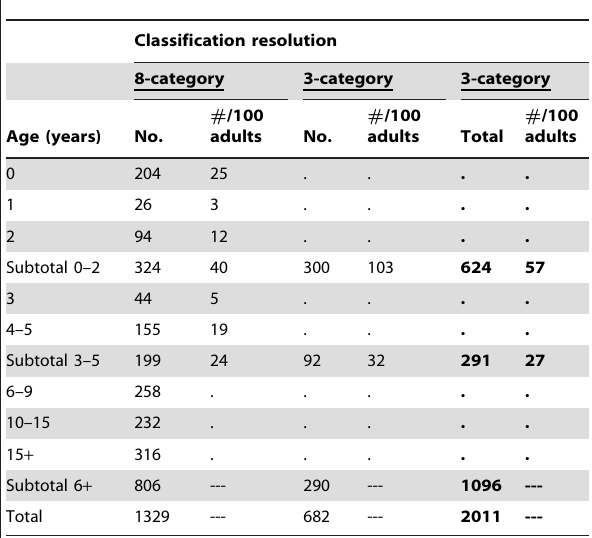
Table 3. Numbers of female and young (known males removed) Pacific walruses in each age class based on 8- category and 3-category classifications of samples from herds hauled out on the northwest coast of Alaska in fall of 2010 and 2011.